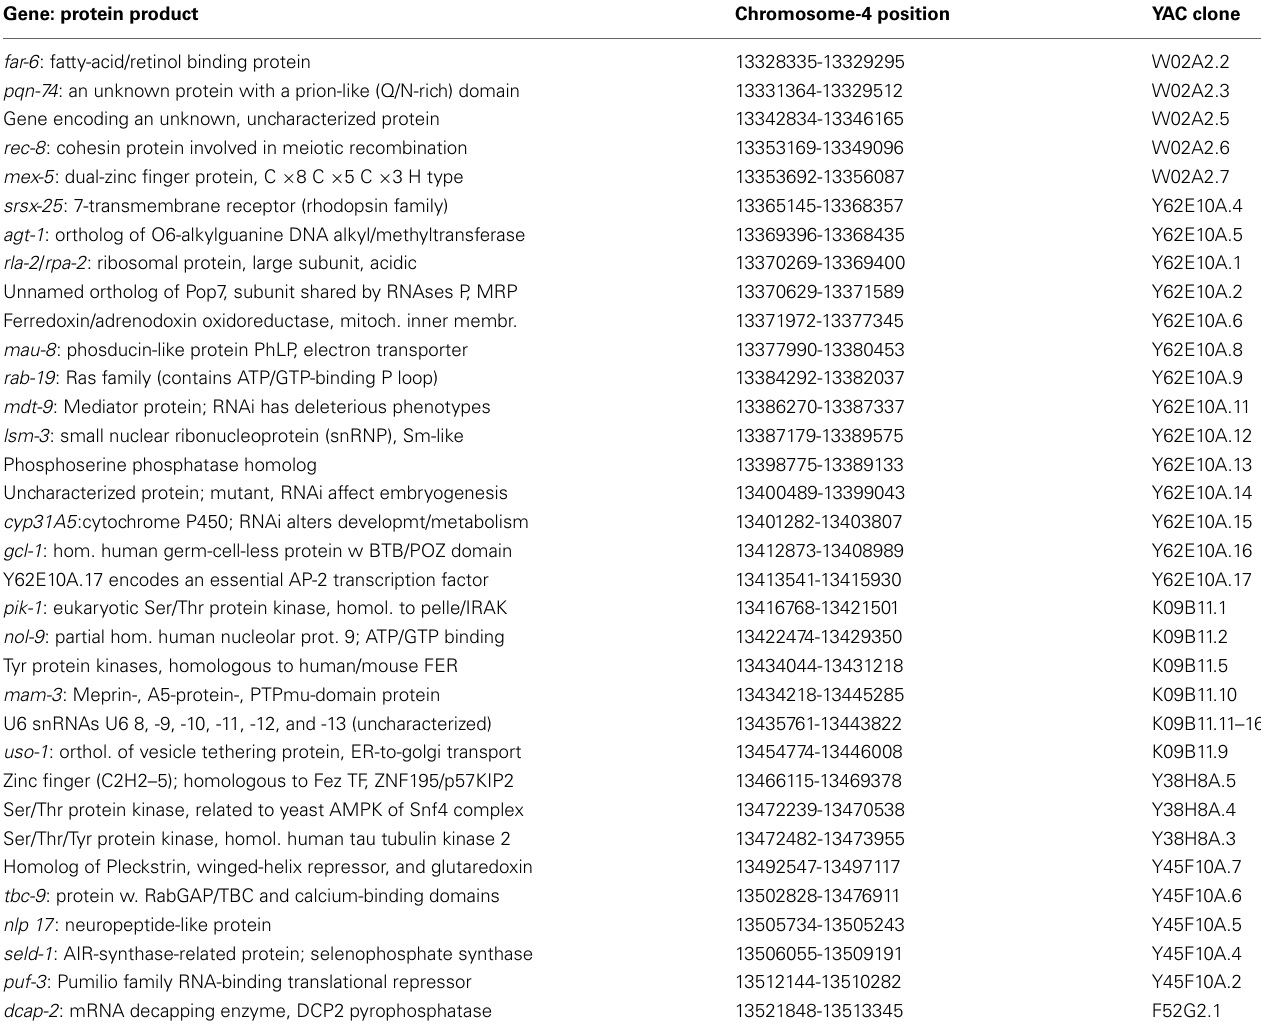
Table 2 | Genes in the lsq4 interval—positional candidates for life-span determinants. Gene: protein